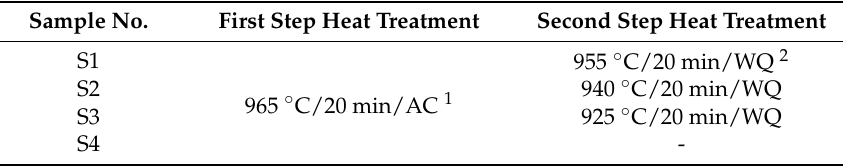
Table 1. Double heat treatment routes of TA15 alloy samples. Sample No. First Step Heat